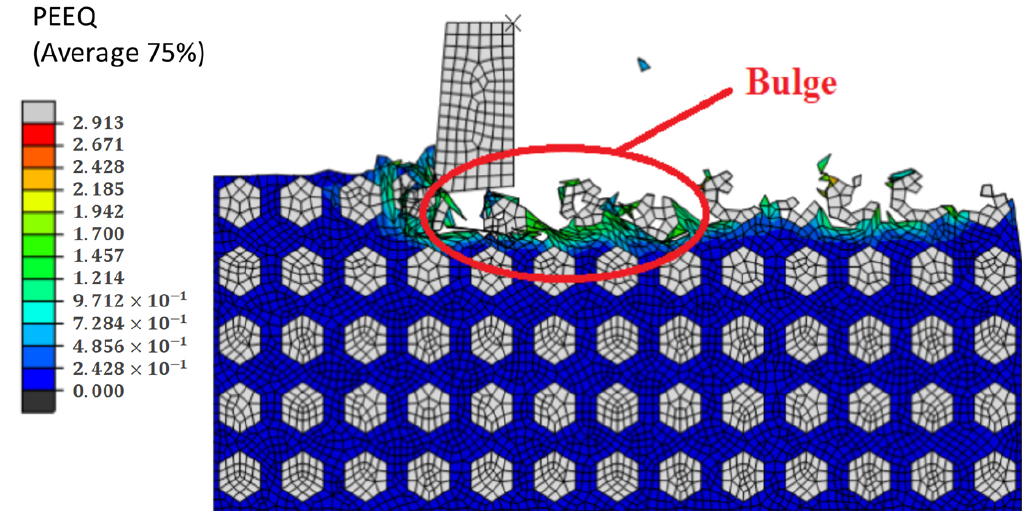
Materials 2021 , 14 , x FOR PEER REVIEW Figure 25. Simulation results of a machined surface bulge. Figure 25. Simulation results of a machined surface bulge.